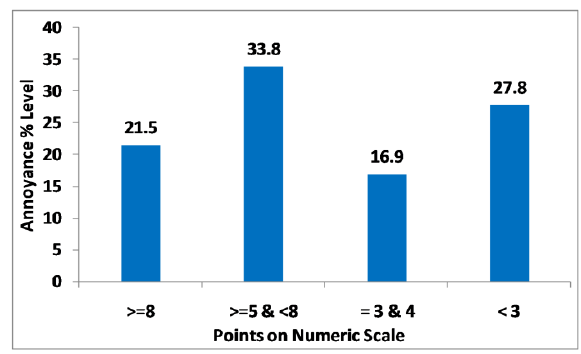
Figure 4. Noise annoyance percentage levels on the numeric scale